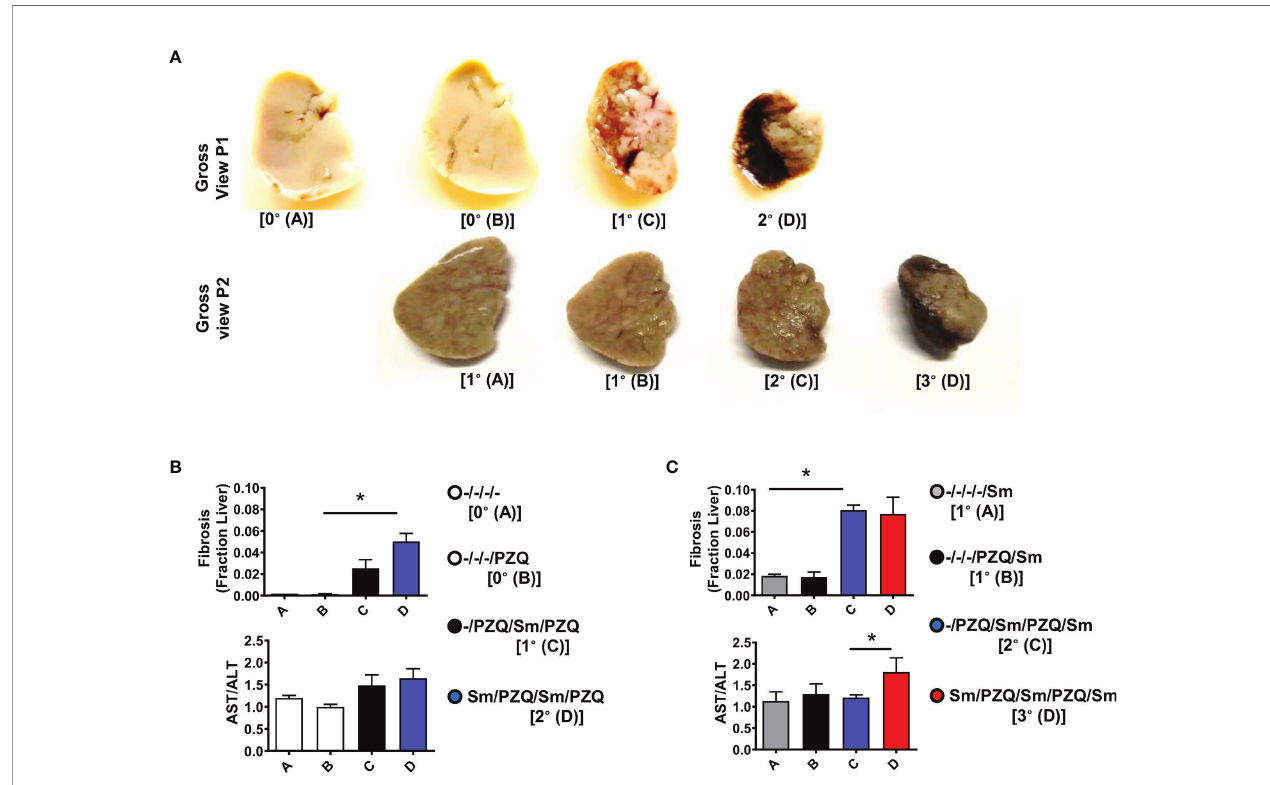
FIGURE 4 | Liver fi bropathology after repeated cycles of S. mansoni infection and PZQ treatments. Outcome measure = Advancement of liver fi broproliferative processes in animals (A) Upper panel shows a gross view of larger liver lobe of mice after differential scheme of infection/PZQ treatments after 15 weeks (P1) and lower panel illustrated the liver lobes after 25 weeks (P2). Note that resolution for both time points differs. For P1, (B) upper panel shows Fraction areas of fi brosis (blue deposition of collagen) over the entire lobe scanned are computed as a proxy for the stage of advancement of liver fi brosis and lower panel shows serum AST/ ALT ratios computed for mice groups subjected to different schemes of infection/PZQ treatments. For P2, (C) upper panel shows Fraction areas of fi brosis (blue deposition of collagen) over the entire lobe scanned are computed as a proxy for the stage of advancement of liver fi brosis and lower panel shows serum AST/ALT ratios computed for mice groups subjected to different schemes of infection/PZQ treatments. Data shown are means ± SEM from one of 2 experiments, with 4-7 mice per group each. * = p < 0.05 as determined Kruskal-Wallis test with correction for multiple comparisons by Dunn ’ s test. Only signi fi cant comparisons between groups are